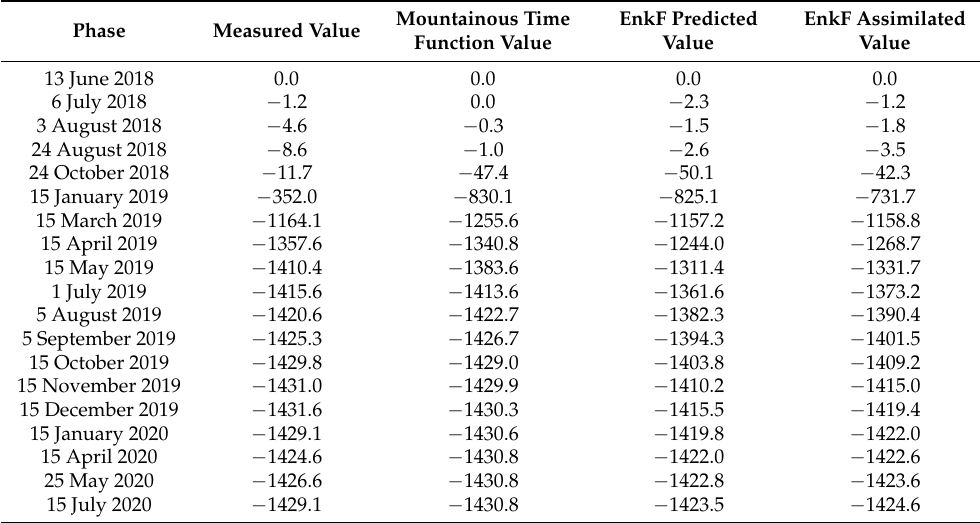
Table A5. The subsidence values of the observation point A36 acquired by different methods